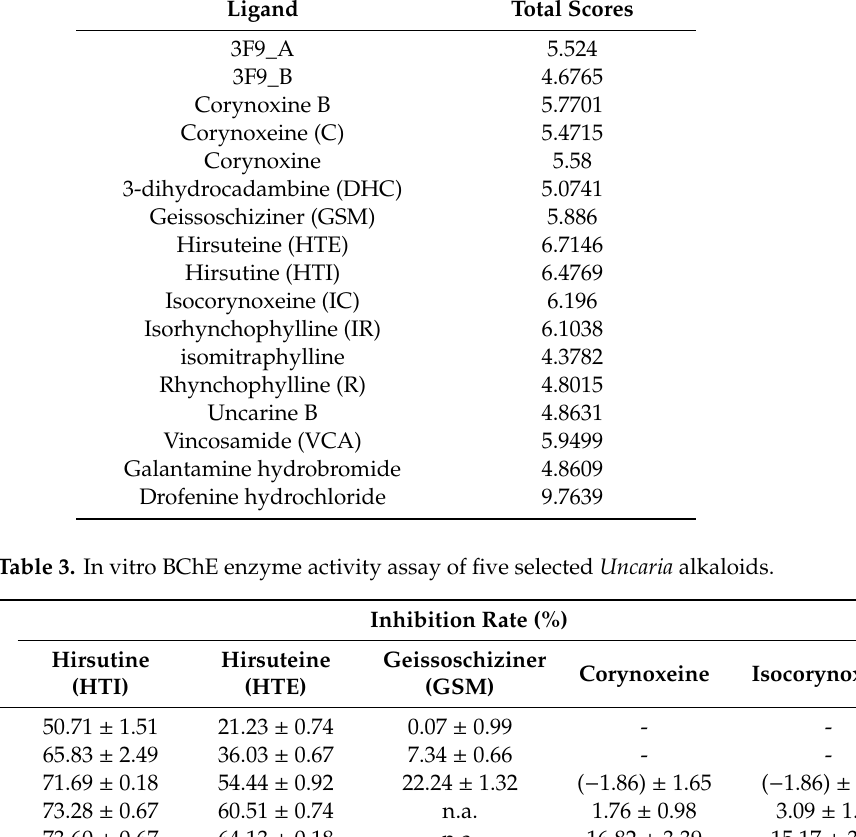
Table 2. Selected Uncaria alkaloids and their total scores from molecular docking analysis using SYBYL-X 2.0 Software.